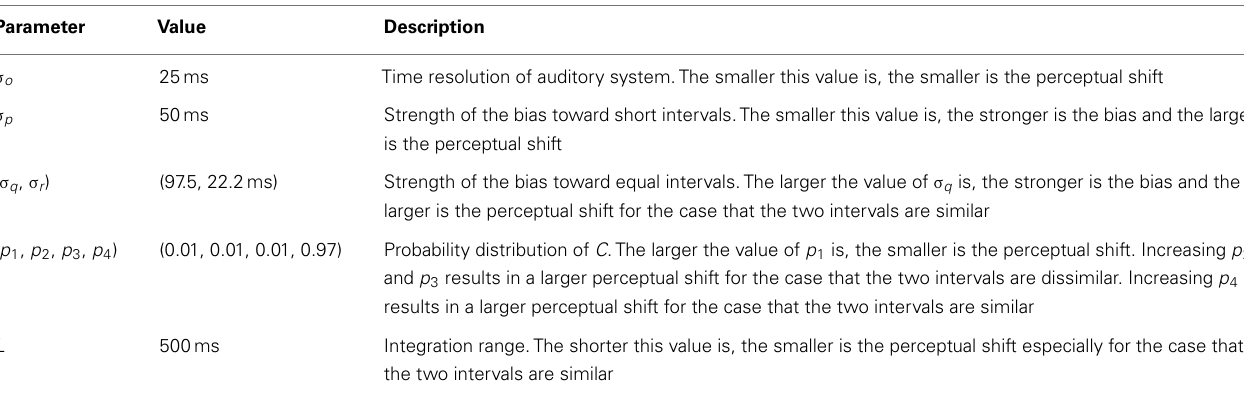
Table 1 | Parameter values in the